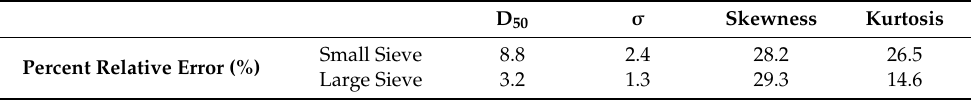
Table 3. Percent Relative Error (%) calculated for granulometric parameters obtained with small and large sieves taking as a reference the laboratory sieve results (the standard procedure). σ : Standard